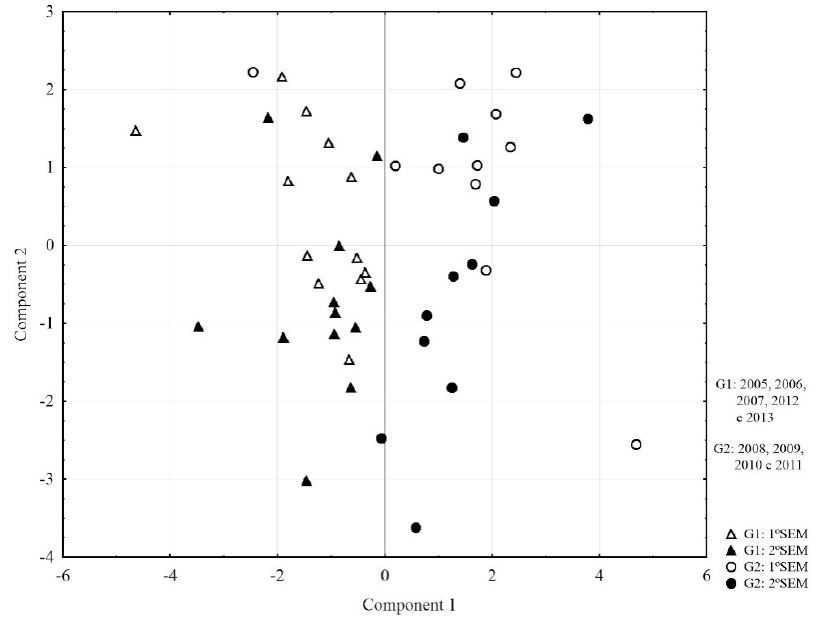
Figure 4. Scores of components plotted on the PC1 × PC2 plane.